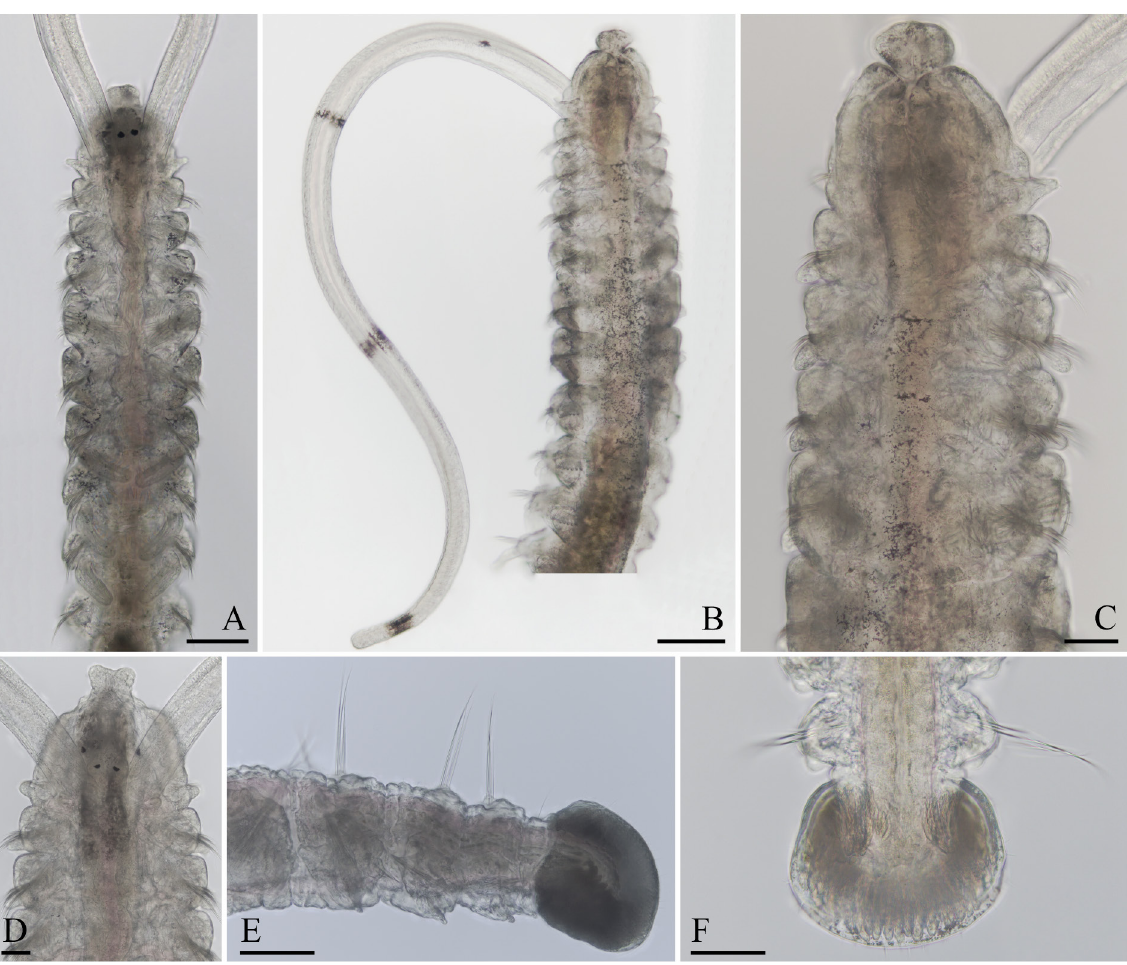
Fig. 13. Adult morphology of Pseudopolydora kuwaiti sp. nov. (live individuals, MIMB 40713). A–D . Anterior ends, dorsal (A, D) and ventral (B–C) view. E – F . Posterior ends, left lateral (E) and dorsal (F) view. Scale bars: A = 500 µm; B–C = 200 µm; D = 100 µm; E = 50